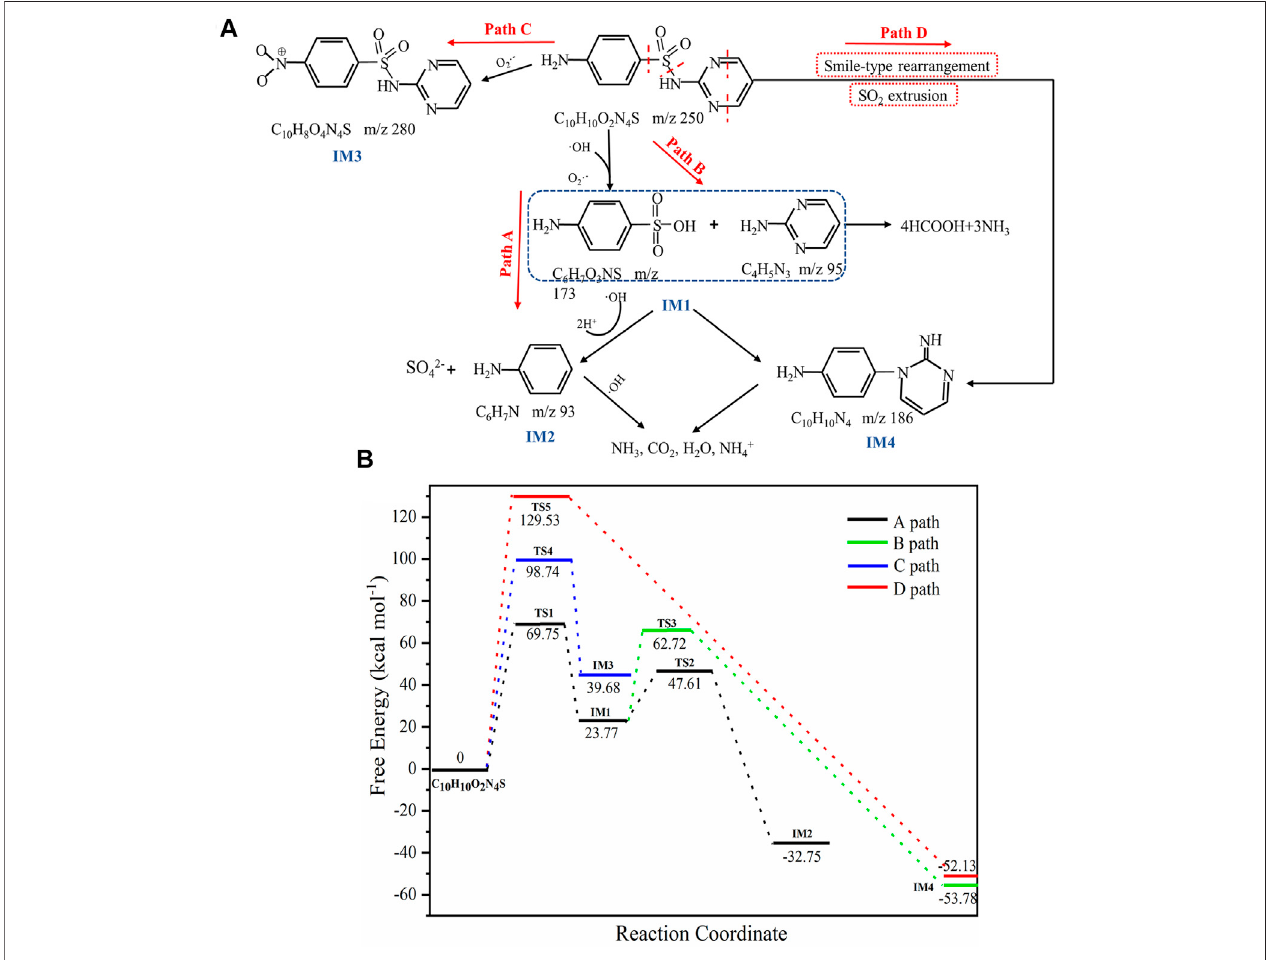
FIGURE 9 | (A) Possible pathways for catalytic photodissociation of SDZ, (B) the potential energy pro fi le, and the resulting transition state of the reaction.